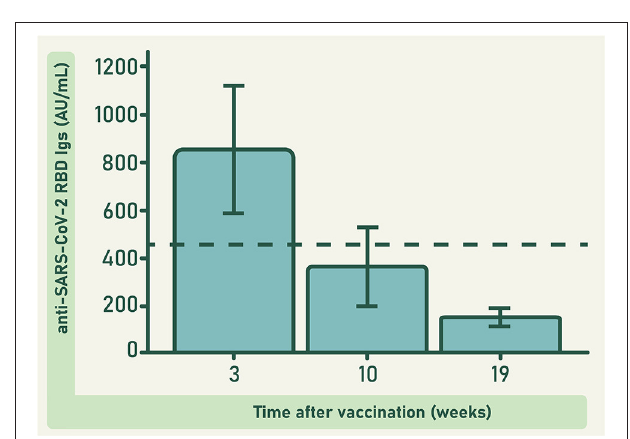
5 EU/kg), divided by the maximum total dose administered to a 100 kg-patient for 1 h (i.e., 120 mL; USP, 2014b).